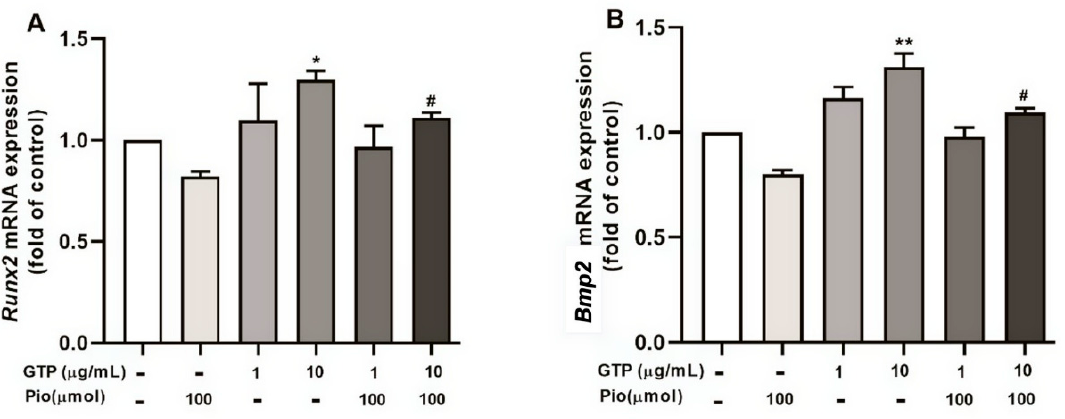
Figure 6. Green tea polyphenols (GTPs) upregulate Runx2 and Bmp2 mRNA expression in mature osteocytes. The gene expression of Runx2 ( A ) and Bmp2 ( B ) analyzed with qRT-PCR in the cell underwent 14 days of oestrogenic induction with a variety of treatments. Data from 4 separate experiments are expressed as means ± SE. * p < 0.05 and ** p < 0.01 GTPs treatments vs. control. # p < 0.05 GTPs plus pioglitazone vs. pioglitazone alone.